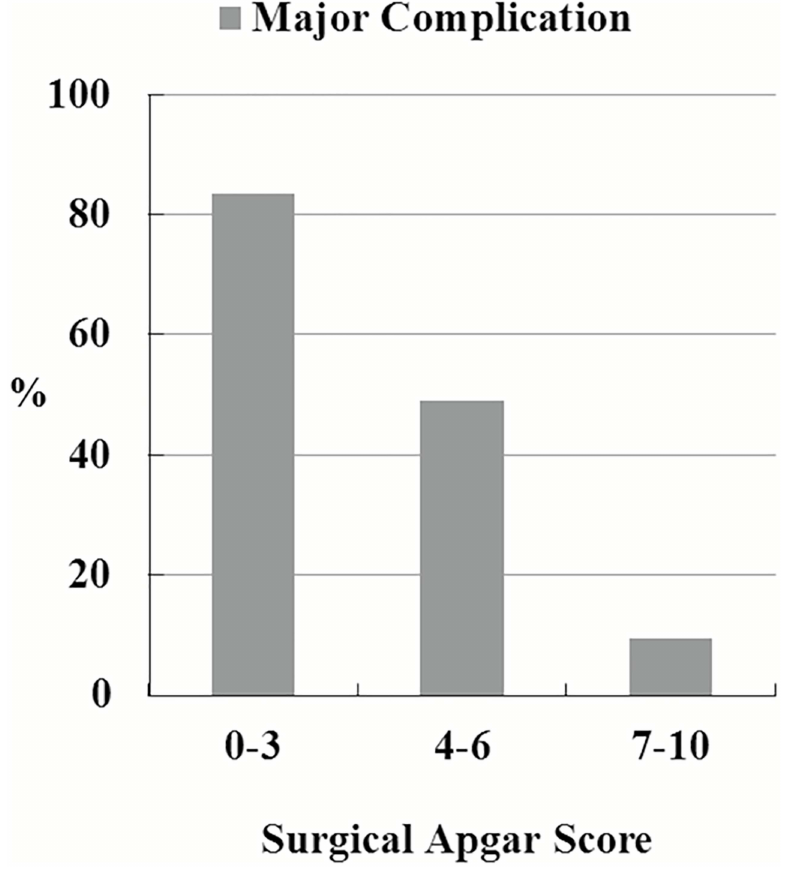
Fig 1. Surgical Apgar Score versus major